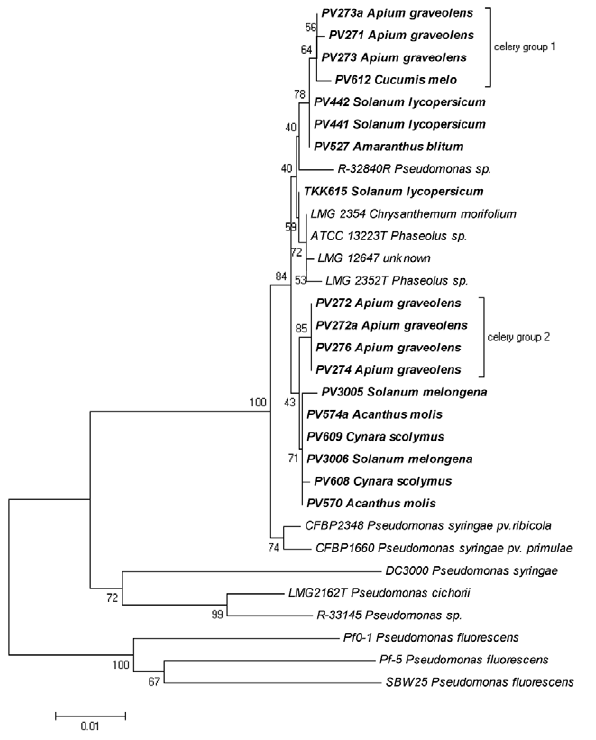
Figure 5. P. viridiflava phylogenetic trees, utilizing rpoB sequences along with sequences obtained from GenBank. The evolutionary history was inferred using the Neighbor-Joining method. Tree construction and evolutionary distances were carried out as described in the Figure 2 legend. The analysis involved 27 nucleotide sequences. All positions containing gaps and missing data were eliminated. There were a total of 741 positions in the final dataset. The methodology used for the evolutionary analysis, tree construction and other details are described in the Figure 3 legend.